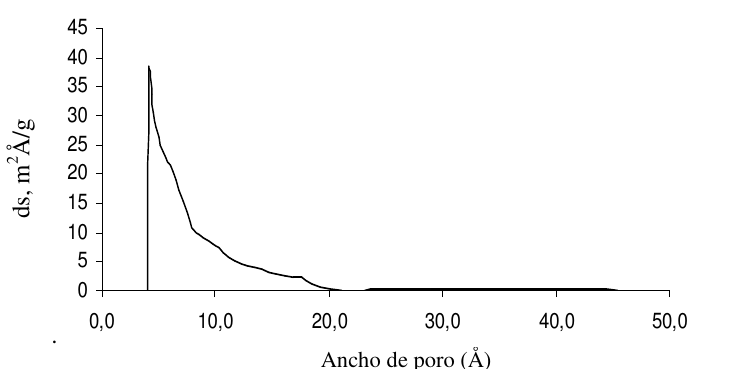
Figure 12 . Pore size distribution of the sieve synthesized from sample 3.